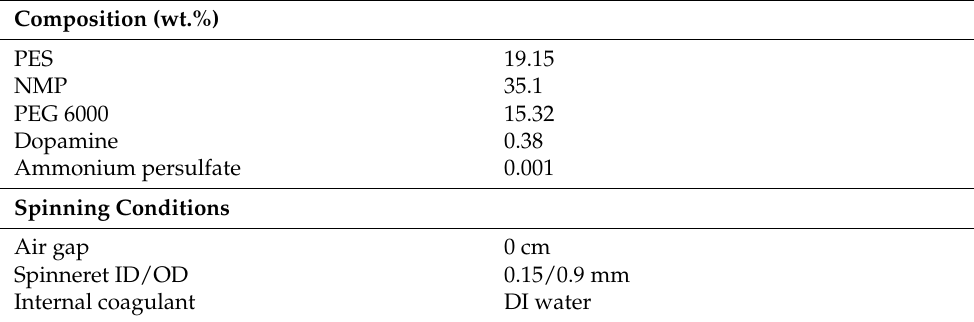
Table 1. Composition of the dope solution and spinning conditions for the preparation of PES hollow fiber